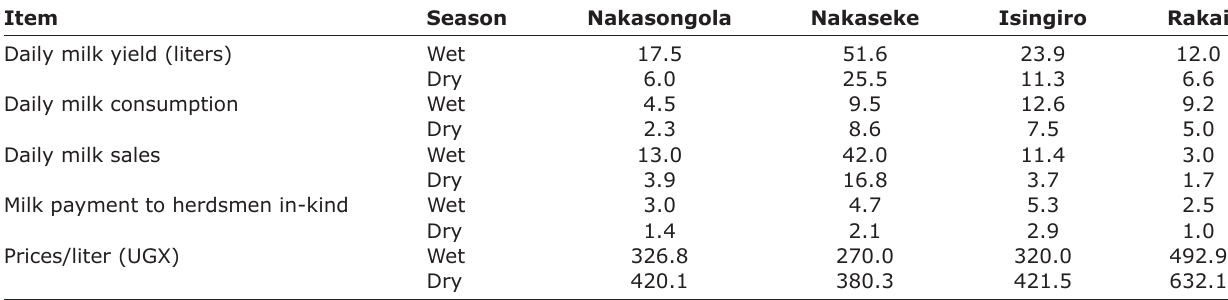
Table-1: Average household daily milk production, consumption, and sales; and prices during the wet and dry seasons in the study districts. Item